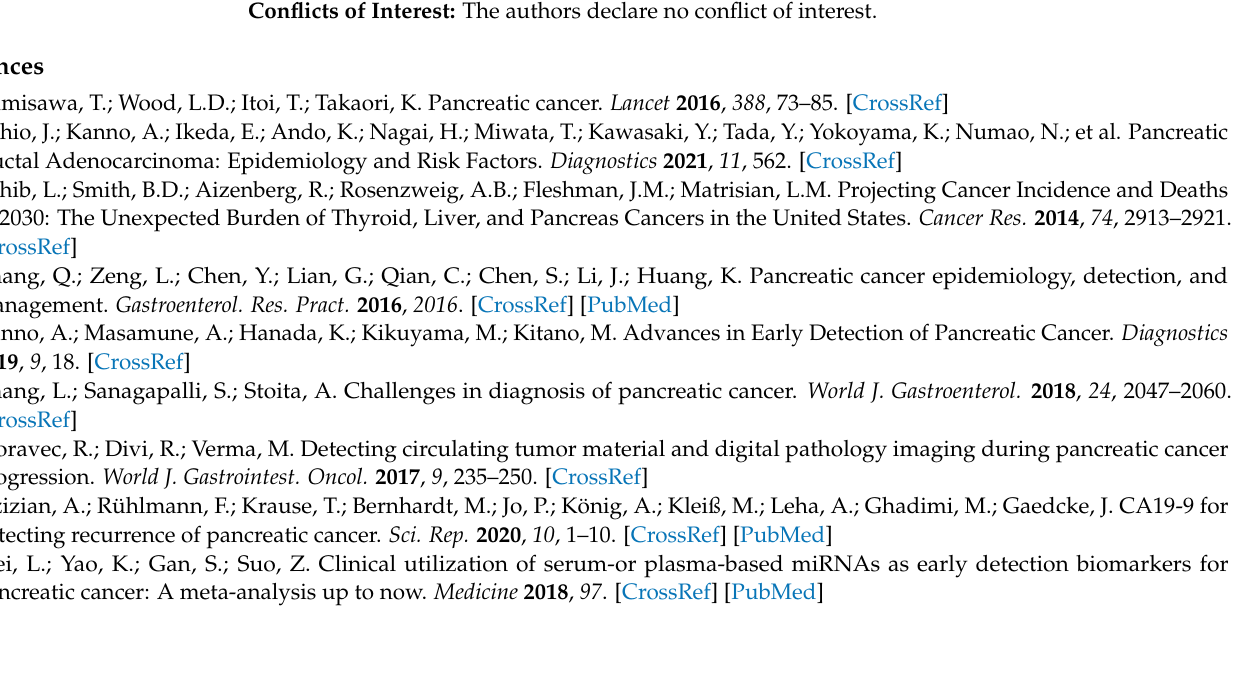
(BCA), Figure S2: Distribution of systemic inflammatory response biomarkers (SIRBs), Figure S3: Characterization of GO and GO-HP complexes, Figure S4: Inter-user reproducibility, Figure S5: Protein contents, Figure S6. Correlation between CEA and CA 19.9 levels and the distance from the cut-off determined by linear discriminant analysis, Table S1: Characteristics of patients included in the training set, Table S2: Comorbidities of patients included in the training set, Table S3: Characteristics of patients included in the validation cohort, Table S4: Comorbidities of patients included in the validation cohort, Table S5. Inter-user reproducibility, Video S1: Sample